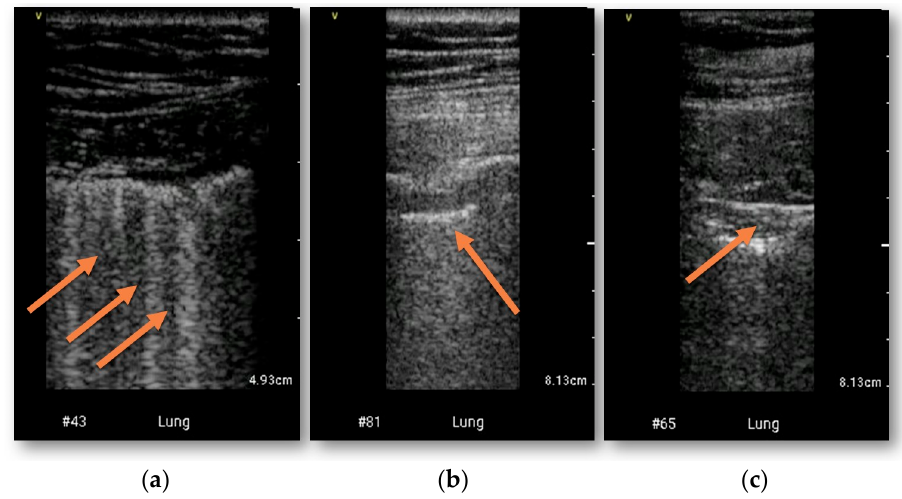
Figure 1. Examples of lung ultrasonography performed with HUD. ( a ) increased number of B-lines; ( b ) pleural thickening; ( c ) subpleural consolidation (abnormalities marked with arrows).